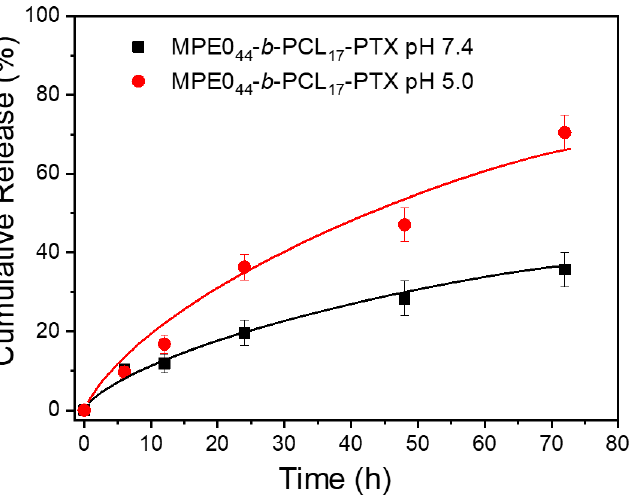
Figure 6. Paclitaxel release profiles from MPEO 44 - b -PCL 17 -PTX NPs at pH ~ 7.4 ( ▪ ) and pH ~ 5.0 ( • ) . The drug-release profile was considered not optimal; however, a yet faster release was expected in contact with more complex media such as the serum-supplied cell culture medium. To investigate the inhibitory effect on tumor cells, the MPEO 44 - b -PCL 17 NPs were loaded with the antitumor drug PTX with an overall cargo rate of around 2.0 wt% (loading efficiency of 92%, see Section 2). Given the hydrophobicity of the NPs core and the PTX (negligible free PTX was observed), no additional purification step was carried out. The cell viability assay was used to document in vitro cytotoxicity as a classical approach to evaluate the direct effect of the drug carrier NPs on target cancer cells. The HeLa cell line was selected as a widely used and well-studied cancer cell model system [47]. The drug-loaded